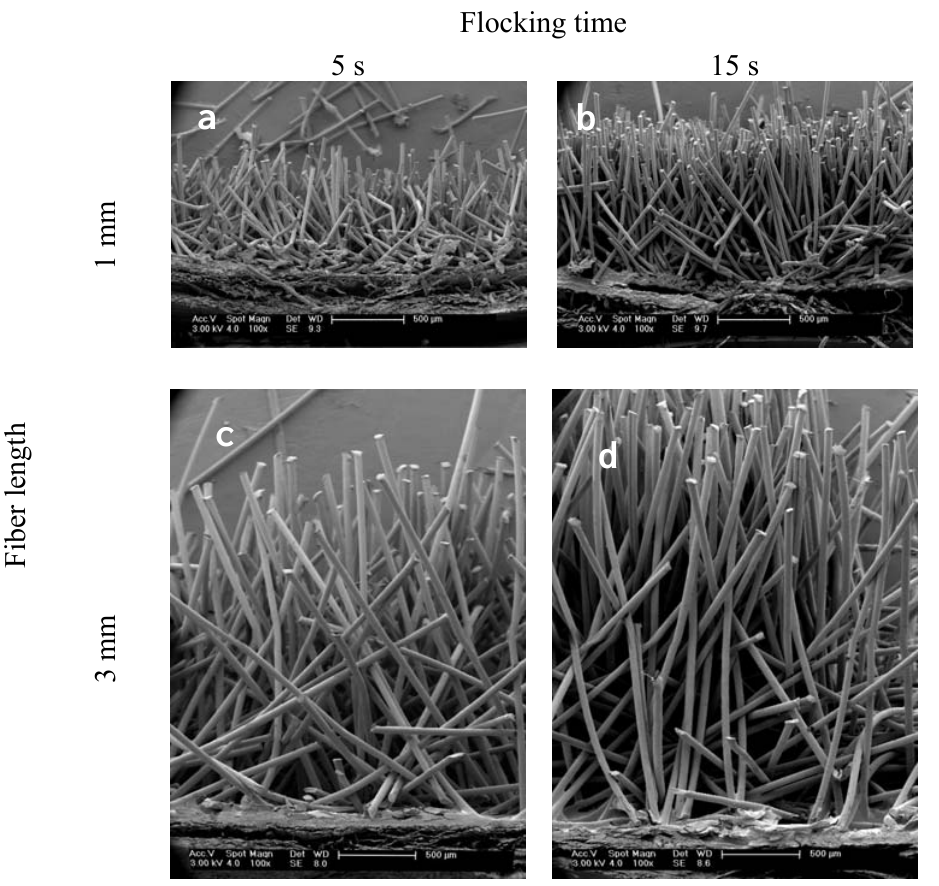
Figure 2. Scanning electron microscopy (SEM) images of scaffolds produced with different flocking times and fiber lengths. The figure shows representative images of longitudinal cuts of the four different scaffold types. ( a ) 1 mm fiber length, 5 s flocking time; ( b ) 1 mm fiber length, 15 s flocking time; ( c ) 3 mm fiber length, 5 s flocking time and ( d ) 3 mm fiber length, 15 s flocking time. Magnification: